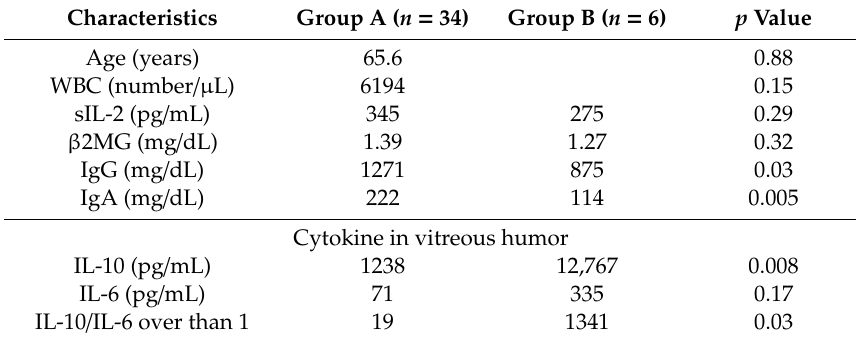
Table 5. Laboratory findings for the two groups, classified based on clustering